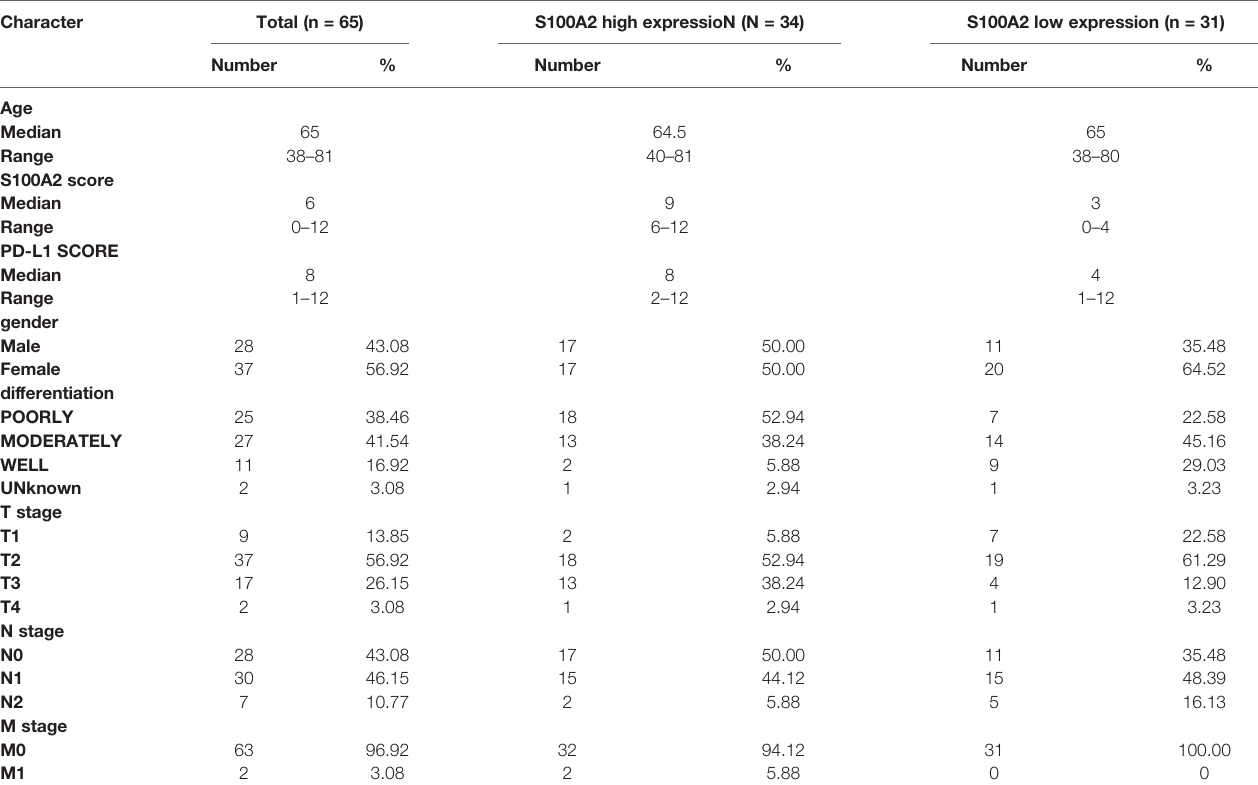
TABLE 3 | Clinical and pathologic information of the PUMCH cohort.